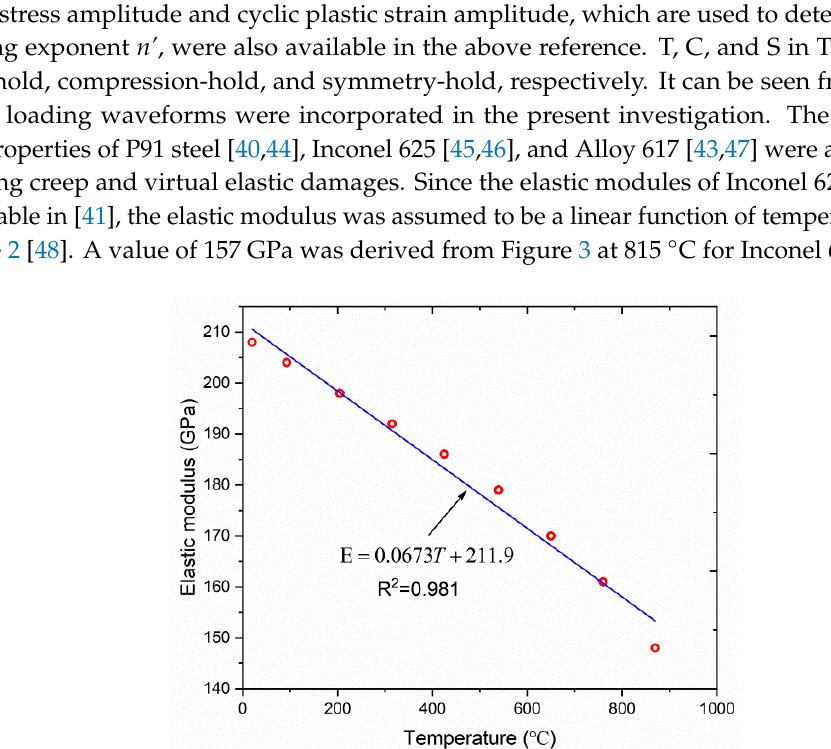
Figure 3. The relation between elastic modulus and temperature of Inconel 625. Table 1. Collected high-temperature fatigue and creep-fatigue test data.